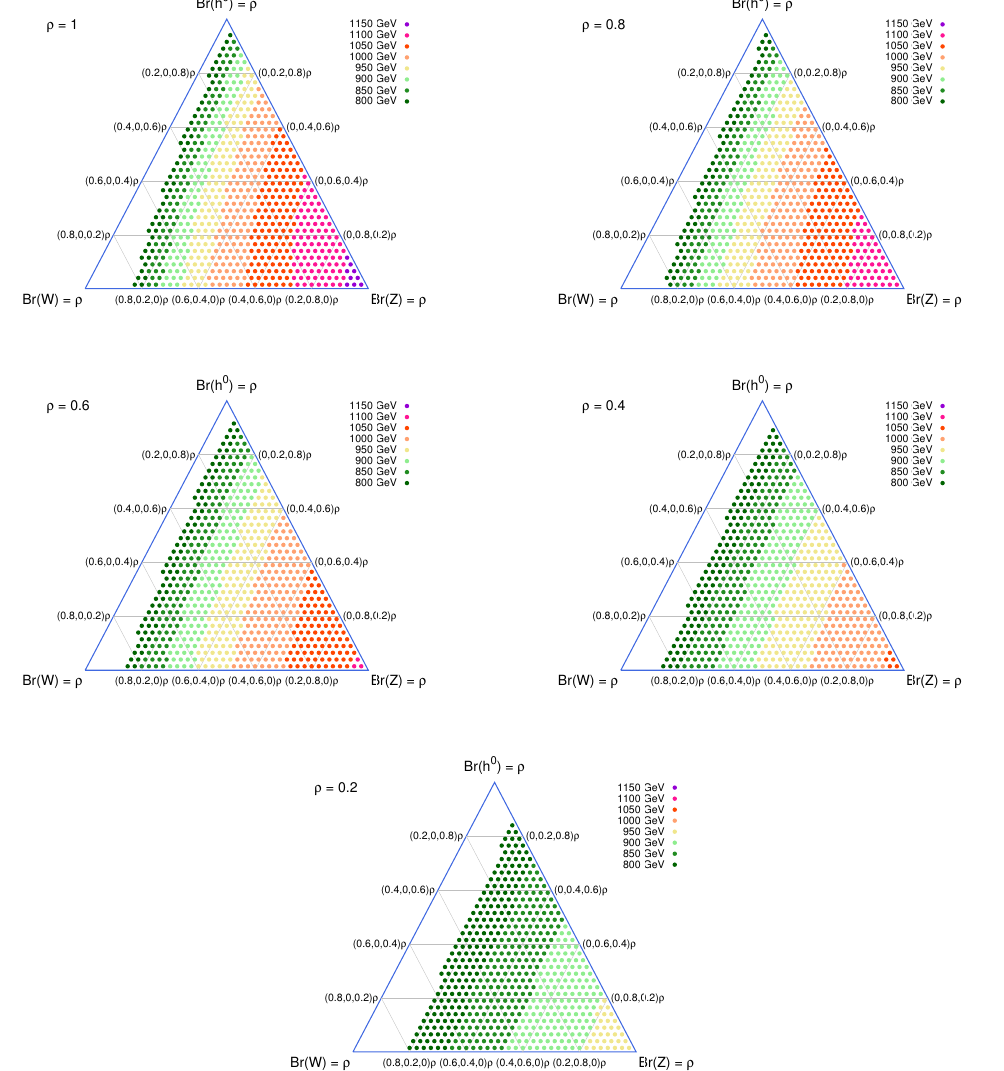
Figure 6 . Lower limits on the T quark mass for several values of (cid:26) (see the text), from a recast of the limits of the heavy quark search in ref.